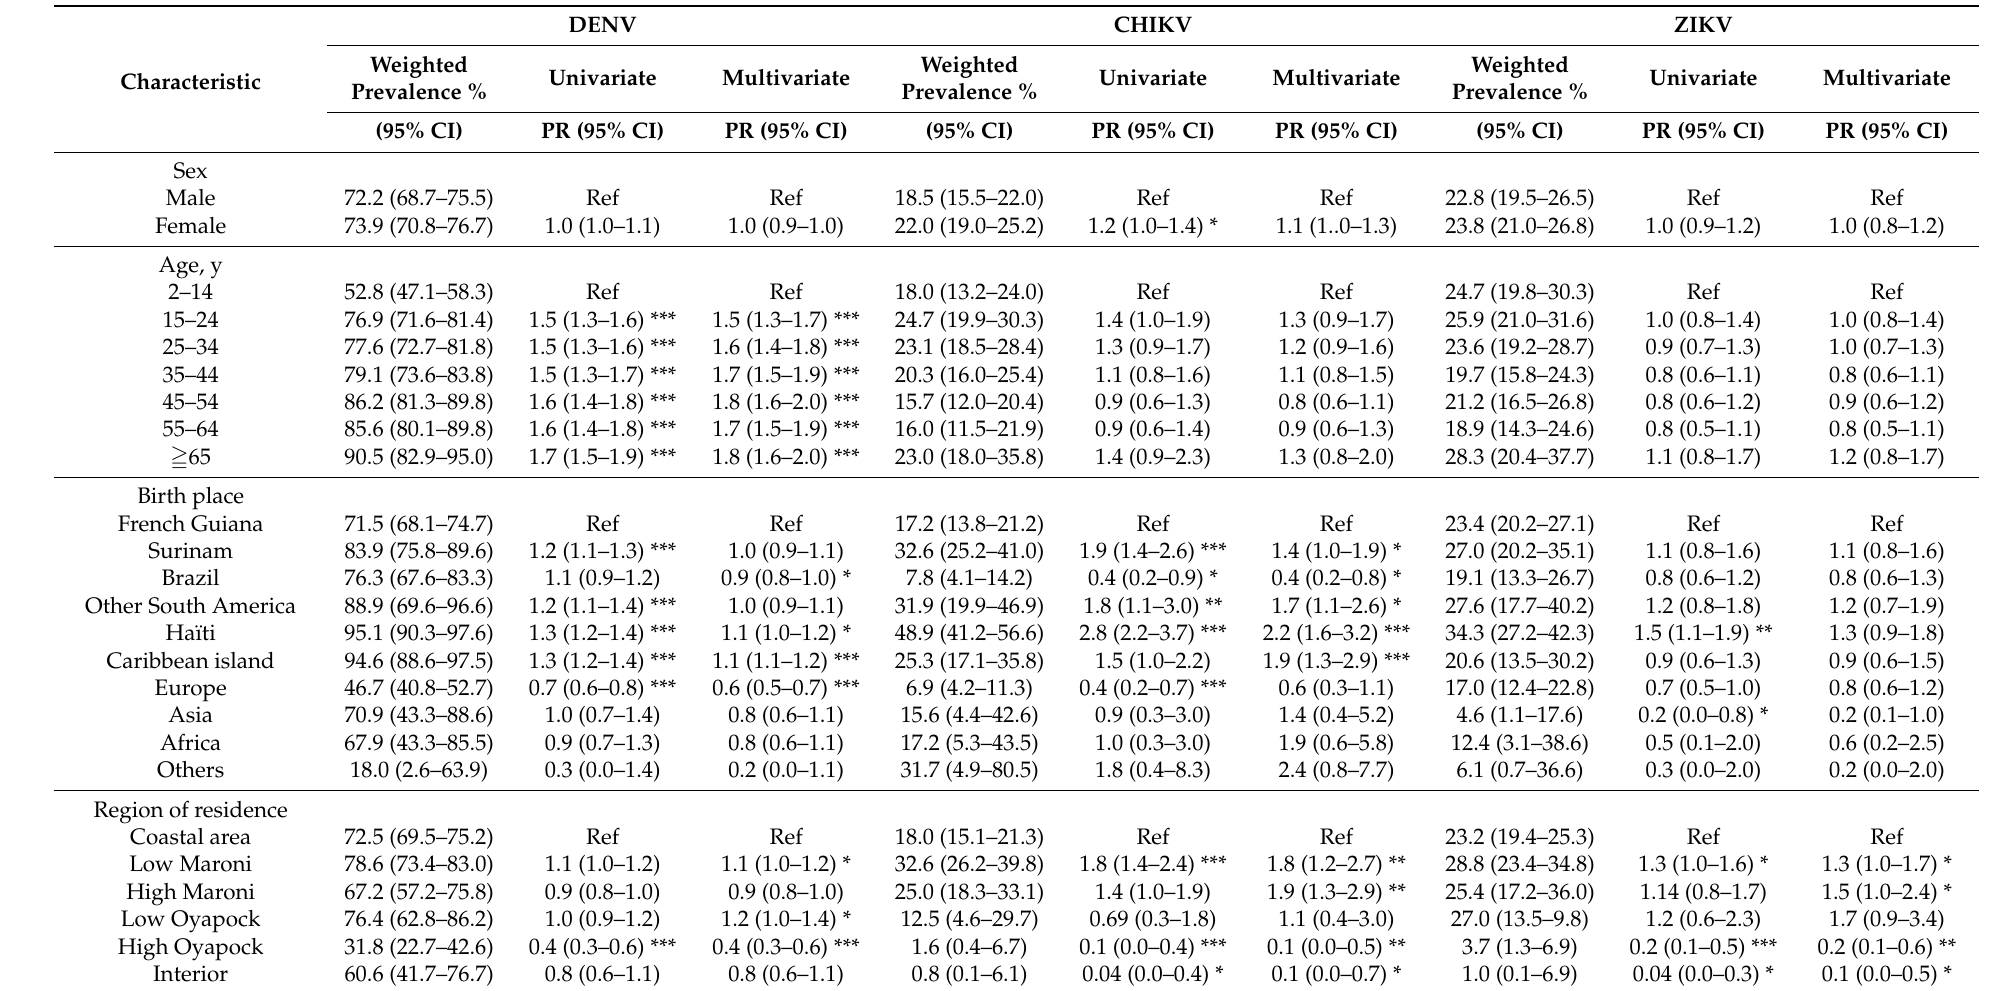
Table 2. Factors associated with DENV, CHIKV and ZIKV